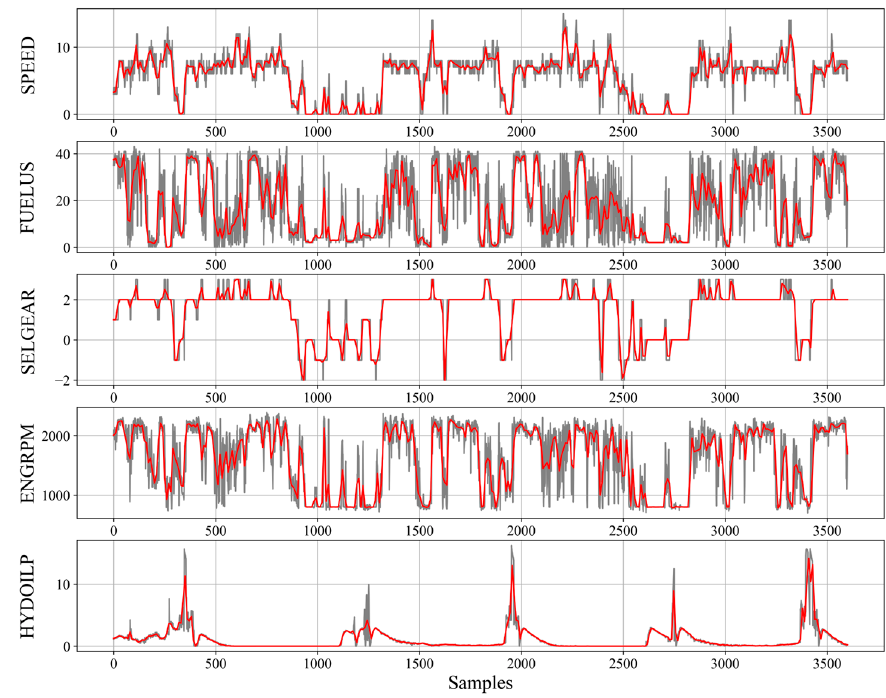
Figure 1. Raw and averaged waveforms of variables used in detection of work cycles. Example generated on data from haul truck.